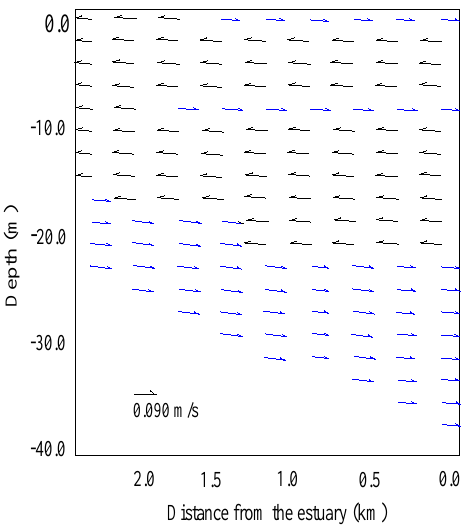
Distance from the estuary (km) Figure 7. Vertical distribution of flow velocity in the Zhuyi Bay during the wet season. Note: The blue arrows represent the water flows from the Zhuyi Bay into the mainstream of the TGR (normal flow velocities), while the black arrows indicate the reverse flow (reverse flow velocities).